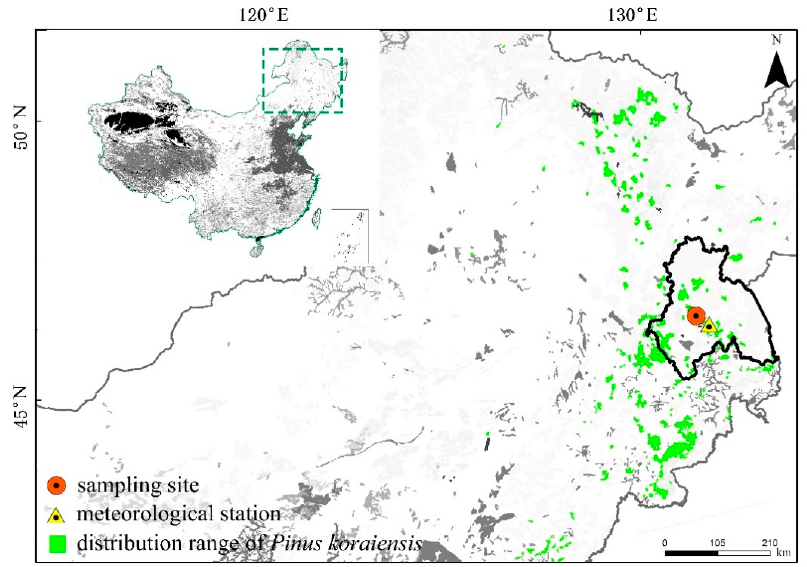
Figure 1. Geographical location of the study site (red circle) and meteorological station (yellow triangle) in China. Green dots represent temperate coniferous and deciduous broad-leaved mixed forests.